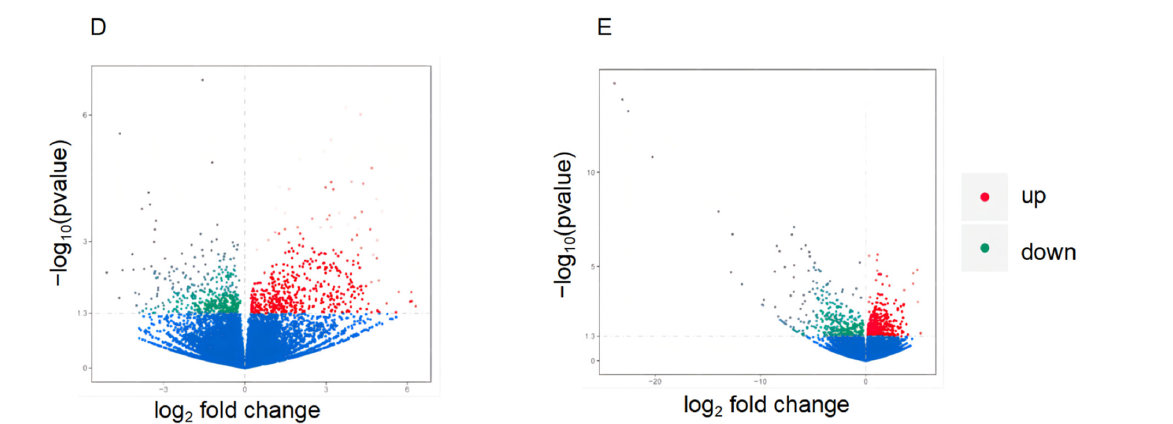
Figure 2. Transcriptomic analysis of MD-4-treated IND-induced gastric ulcerated rats. ( A ): Venn diagram shows the number of differentially expressed genes. Different colors represent different comparisons, adding all the numbers in one circle provides the number of differentially expressed genes for a particular comparisons, while overlapping areas represent common differentially ex- pressed genes when two groups were compared. ( B ): Pearson correlation heat map between samples. The abscissa and ordinate are the square of the correlation coefficient of each sample. ( C ): Cluster heat map of genes that were differentially expressed. The abscissa indicates sample names, with the ordinate being the normalized FPKM vale. Red and green colors indicate upregulation and downregulation, respectively. ( D , E ): Volcano plots showing transcriptome data. ( A , B ): 874 and 821 genes were differentially expressed when comparing the control with IND treatment ( A ) and be- tween IND- and MD-4-treated groups ( B ), respectively. Vertical lines indicate a log2 fold change, while the horizontal ones represent p -value of 0.05. Red and green colors indicate significant up- and downregulation of genes, respectively. Significant DEGs were identified based on a p -value of <0.05 and a log2 fold change of at least 2.0. Control: normal control, IND: indomethacin, MD-4: molor-dabos-4 decoction.